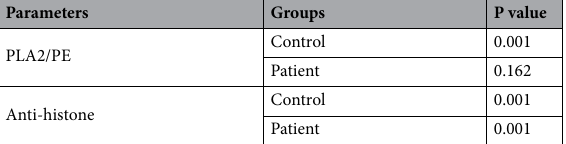
Table 2. Normality of data for each group using Shapiro–Wilk Test. The data is normal distributed for P value > 0.05 and not normal distributed for P value < = 0.05.